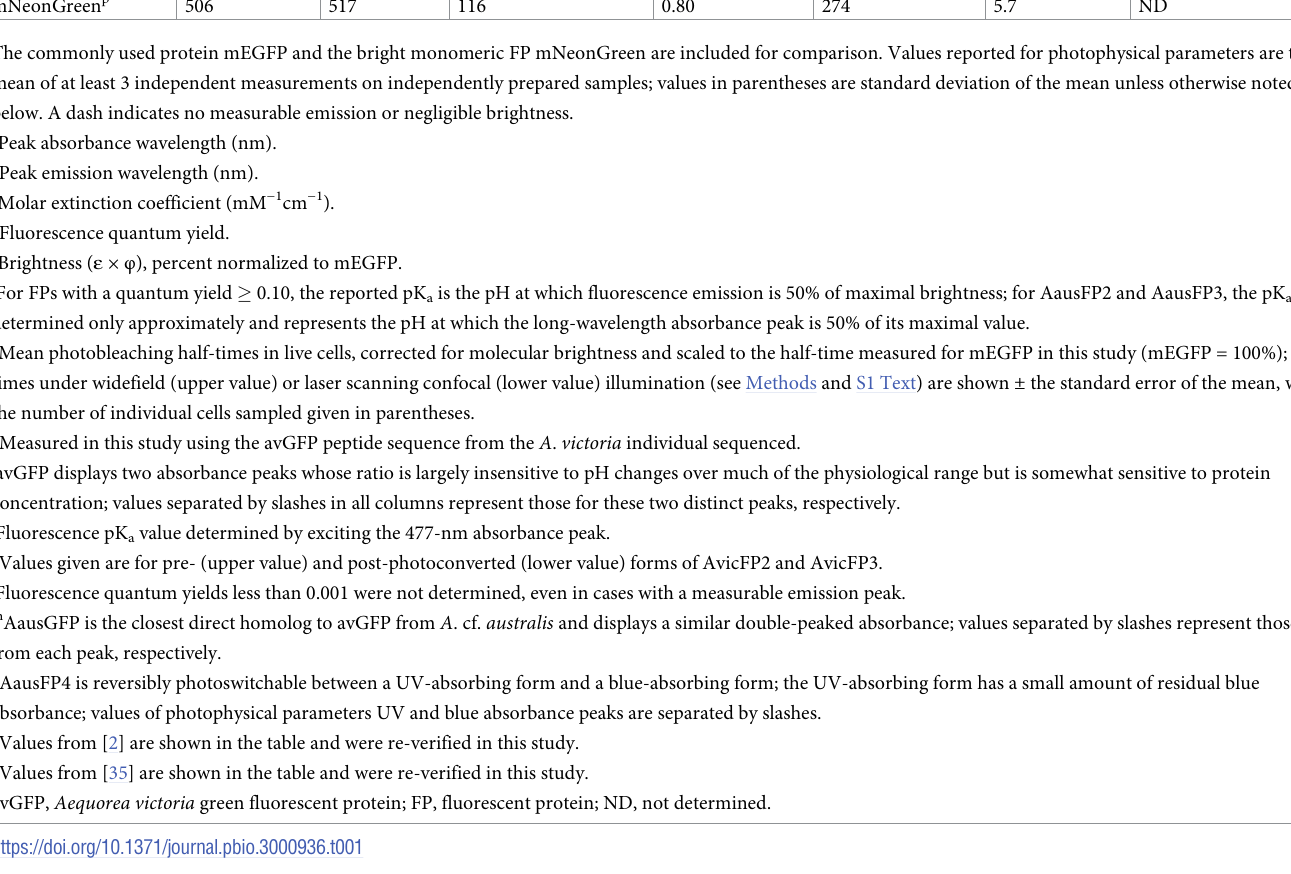
The commonly used protein mEGFP and the bright monomeric FP mNeonGreen are included for comparison. Values reported for photophysical parameters are the mean of at least 3 independent measurements on independently prepared samples; values in parentheses are standard deviation of the mean unless otherwise noted below. A dash indicates no measurable emission or negligible brightness.